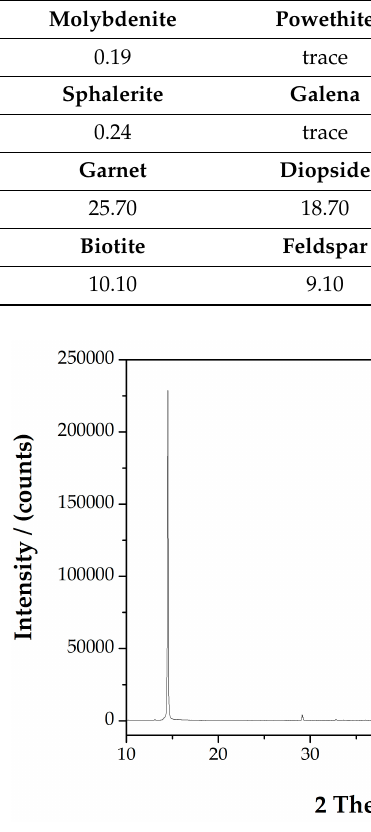
Figure 1. X-ray diffraction (XRD) analysis of the enriched molybdenite sample.